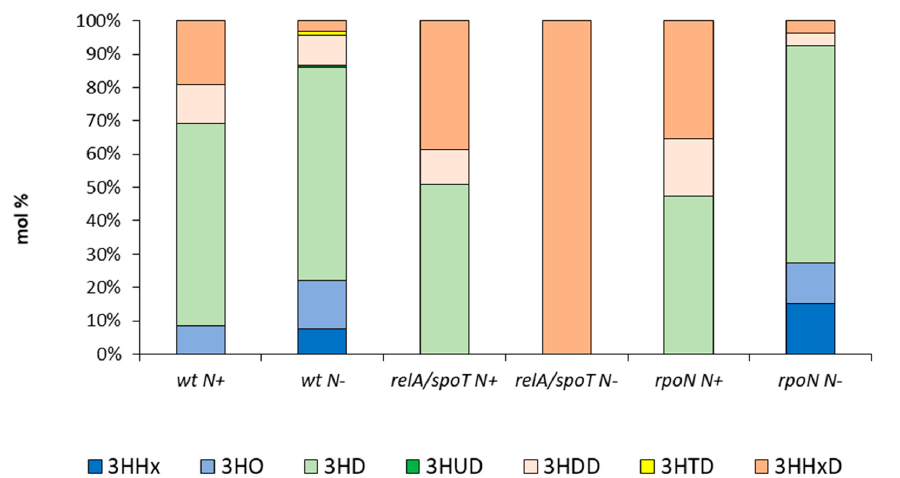
Figure 2. Monomeric composition of mcl ‐ PHAs synthesized by the wild type of Pseudomonas putida KT2440 and the relA/spoT and rpoN mutants grown under optimal (N+) and nitrogen limiting conditions (N − ). Abbreviations: 3HHx, 3 ‐ hydroxyhexanoate; 3HO, 3 ‐ hydroxyoctanoate; 3HD, 3 ‐ hydroxydecanoate; 3HUD, 3 ‐ hydroxyundecanoate; 3HDD, 3 ‐ hydroxydodecanoate; 3HTD, 3 ‐ hydroxytetradecanoate; 3HHxD, 3 ‐ hydroxyhexadecanoate.